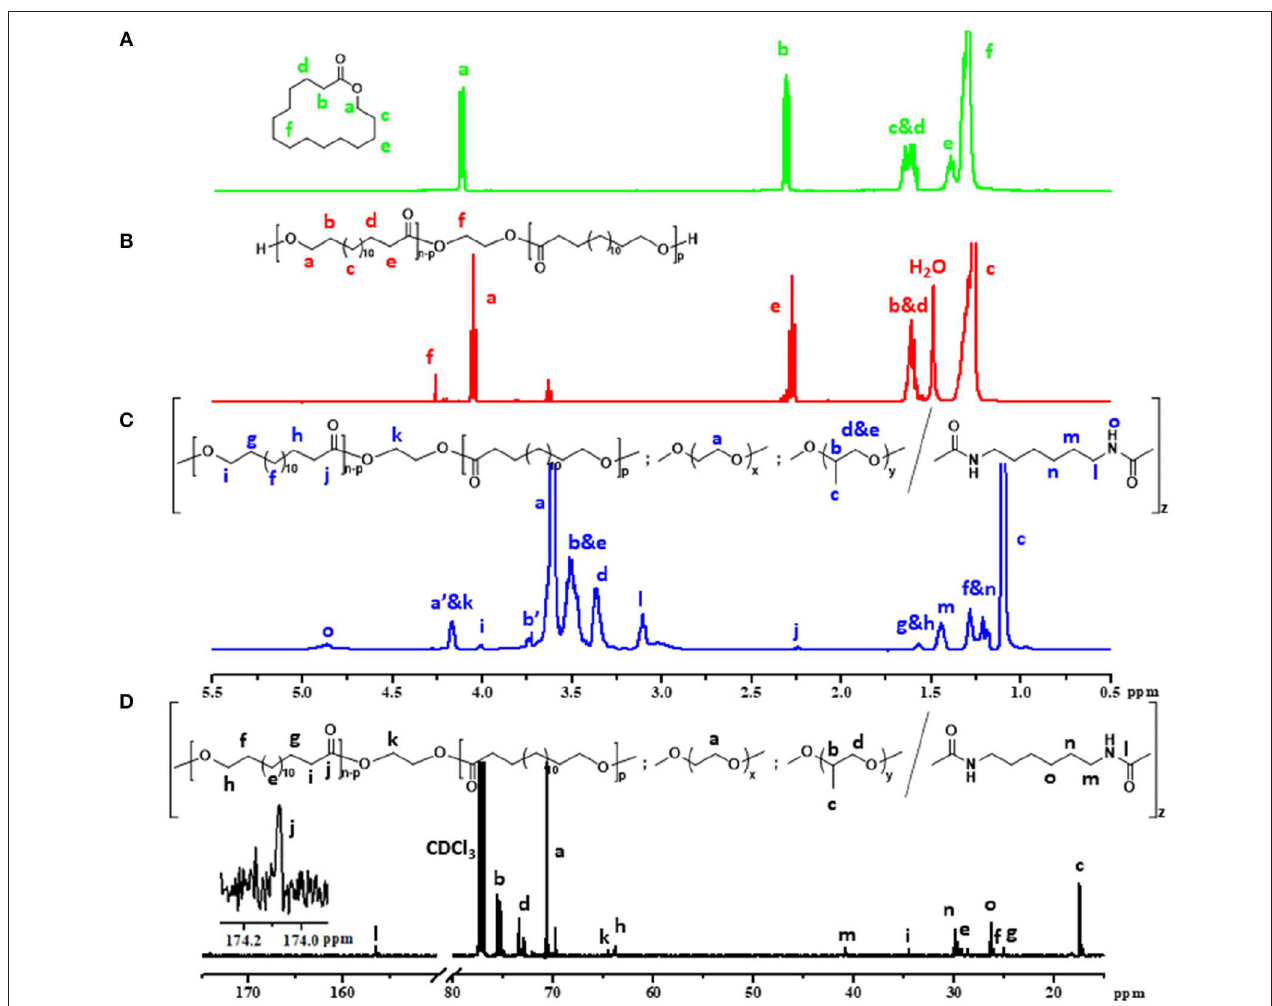
FIGURE 1 | Five hundred megahertz 1 H NMR spectrum of (A) ω -pentadecalactone, (B) PPDL-diol, (C) 2PDEP (a’, b’ represent protons on terminal unit of PEG and PPG segments which reacted with HMDI) and (D) 13 C NMR spectrum of 2PDEP in CDCl 3 .